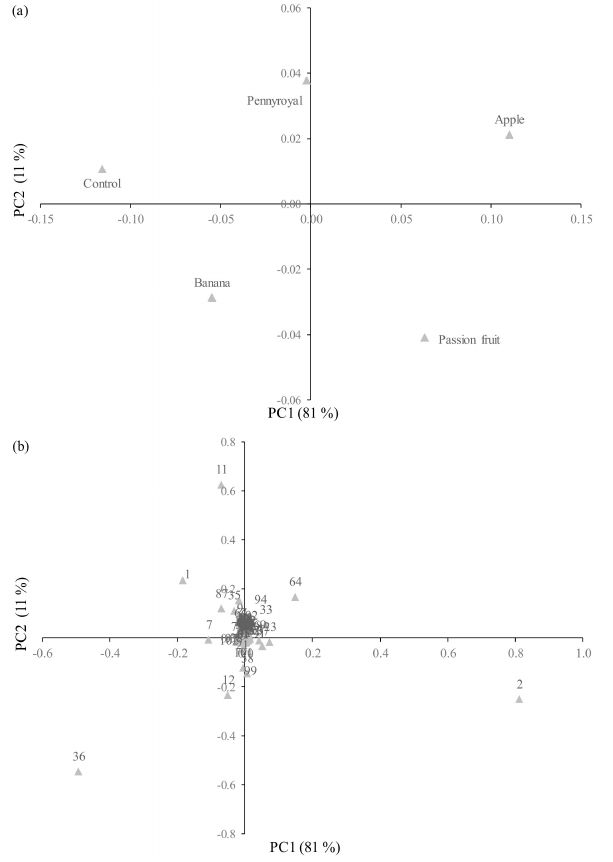
Figure 4. ( a ) Principal components (PC) PC1 × PC2 of scores scatter plot of wine (control) and WBAV vinegars; ( b ) Loading plot of the main source of variability between volatile profile and wine vinegars—derived products by maceration with fruits and plant (attribution of the peak number shown in Table